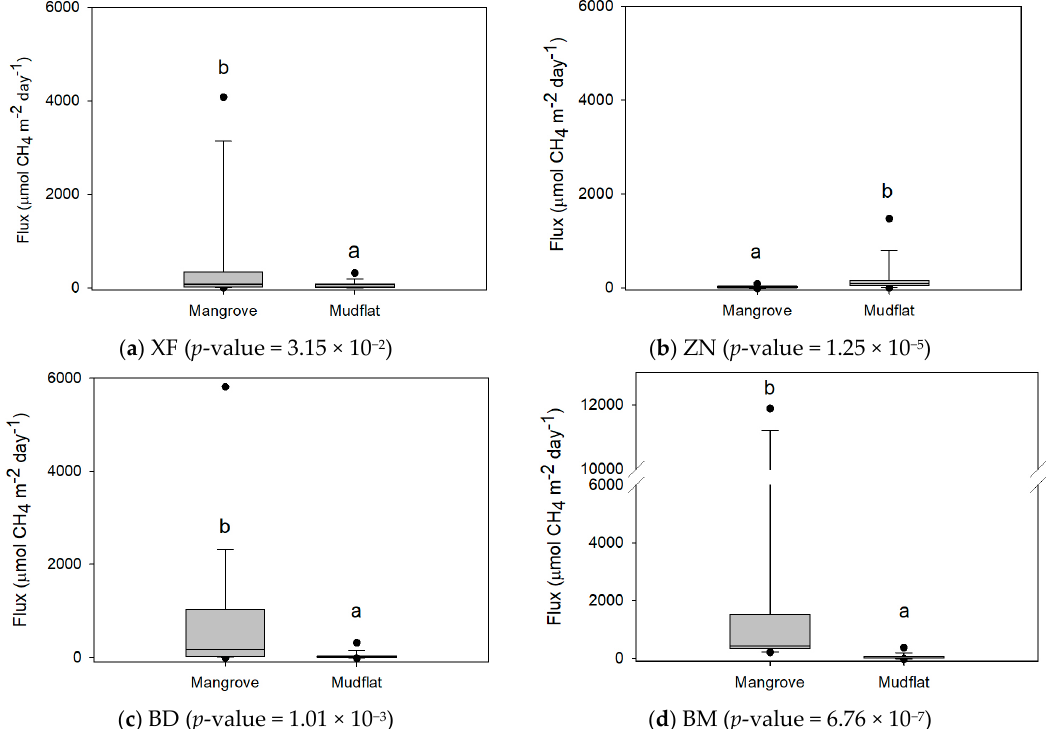
Figure 4. Comparisons of methane fluxes between mangroves and adjoining mudflats at ( a ) Xinfeng (XF), ( b ) Zhunan (ZN), ( c ) Budai (BD), and ( d ) Beimen (BM). Different letters indicate a significant difference ( p < 0.05) with the Wilcoxon rank-sum test. Table 4. Comparisons of methane fluxes and soil parameters between mangroves and adjoining mudflats at the four sites with the Wilcoxon rank-sum test (a significant difference at p < 0.05; n.s. = no significance). ORP: redox potential.